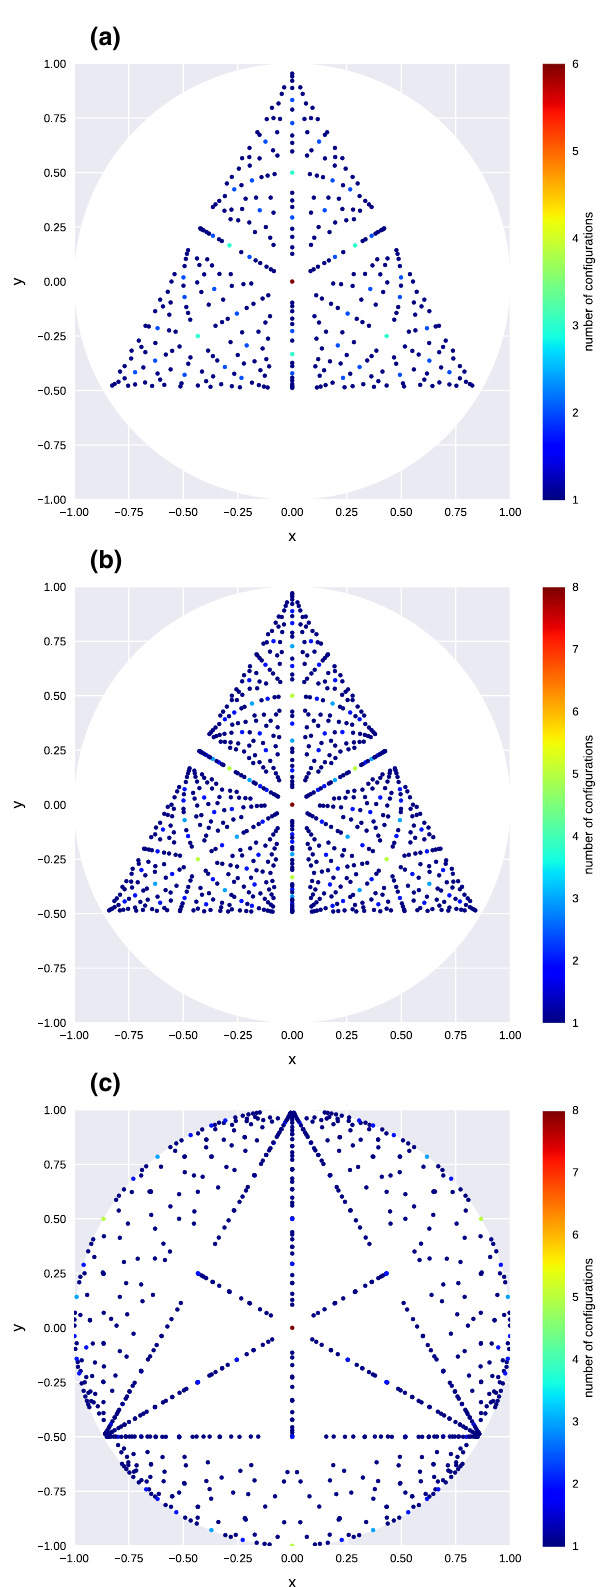
Fig. 1 Distributions of 3q configurations: a Ref. [10] β = 5 . 8 data; b Ref. [10] β = 6 . 0 data; and c Ref. [11] β = 6 . 0 data. The color code denotesthenumberofdifferentsizesforanidenticalconfiguration.Note the small overlap, and the complementarity of the chosen geometries in Refs. [10] and